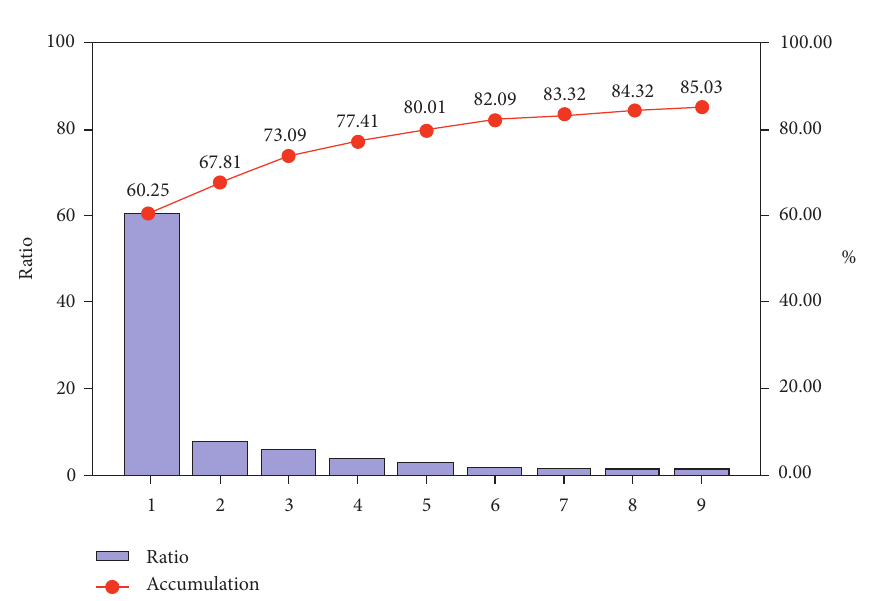
Figure 8: Principal components and their